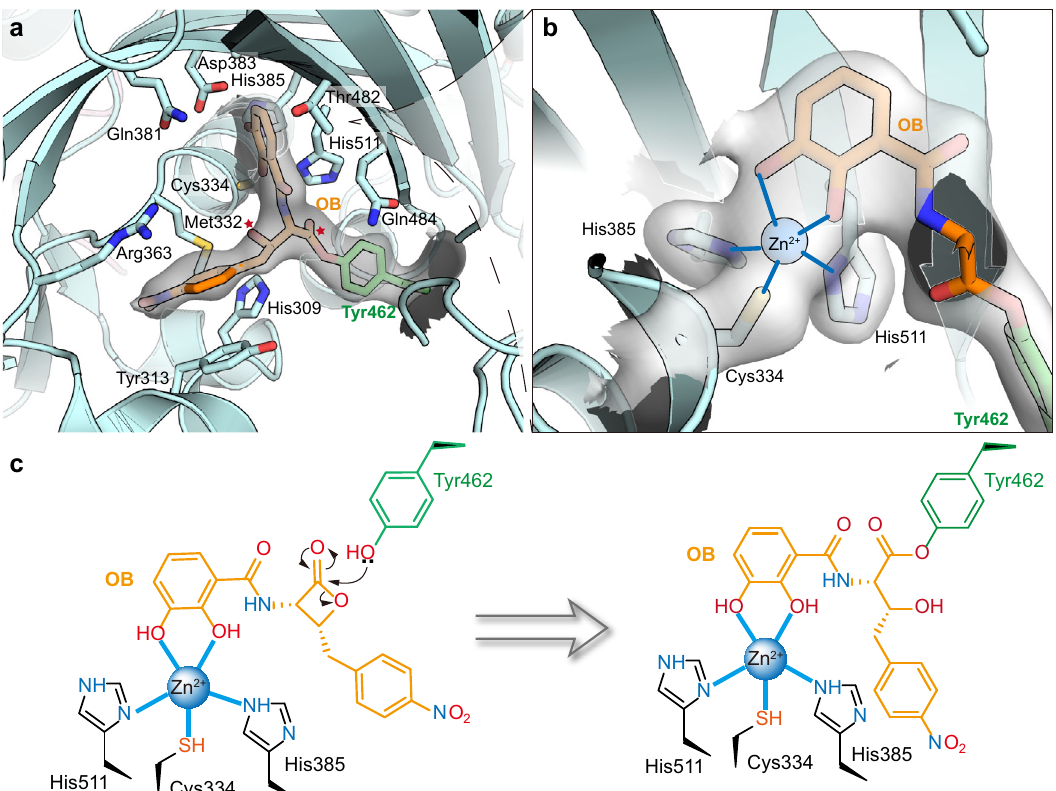
Fig. 2 OB forms a covalent bond with the Tyr462 residue of ThrRS. a The catalytic center of ThrRS with bound OB. The phenolic group of Tyr462 (green sticks) forms a new ester bond with OB (orange sticks). The linkage atoms of the original 4-membered ring in OB are indicated by red stars. Interacting residues are shown as sticks. The 2Fo-Fc electron density of Tyr462-OB (contoured at 1.0 σ ) is shown as a gray transparent surface. b Close-up view of residues coordinating with a Zn 2 + ion. Two hydroxyl groups on the o -diphenol moiety of OB coordinate with a Zn 2 + ion. Residues Cys334, His385, His511, Tyr462, and OB are shown as sticks. The 2Fo-Fc electron density of these residues (contoured at 1.0 σ ) is shown as a transparent surface. c Schematic illustration of the covalent bond formation between ThrRS (Tyr462) and OB.